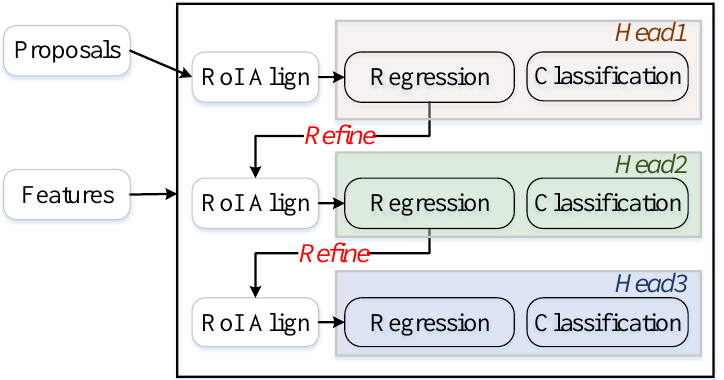
Figure 5. Cascaded RoI heads. Three heads ( Head 1, 2, 3 ) are trained with IoU thresholds of {0.5, 0.6, 0.7},